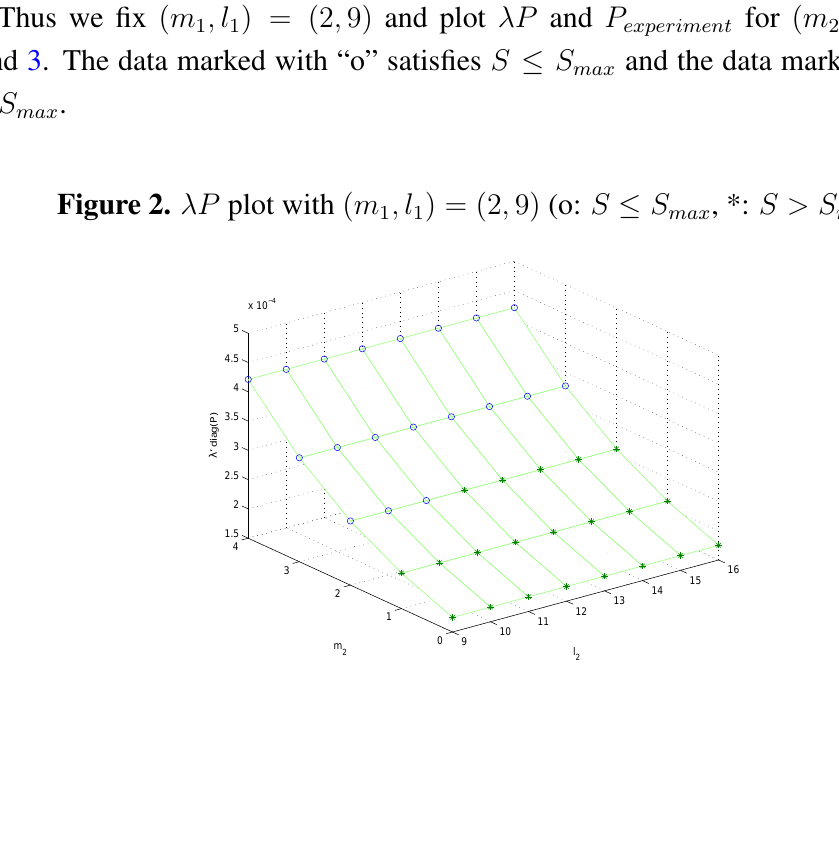
Figure 2. (cid:21)P plot with ( m